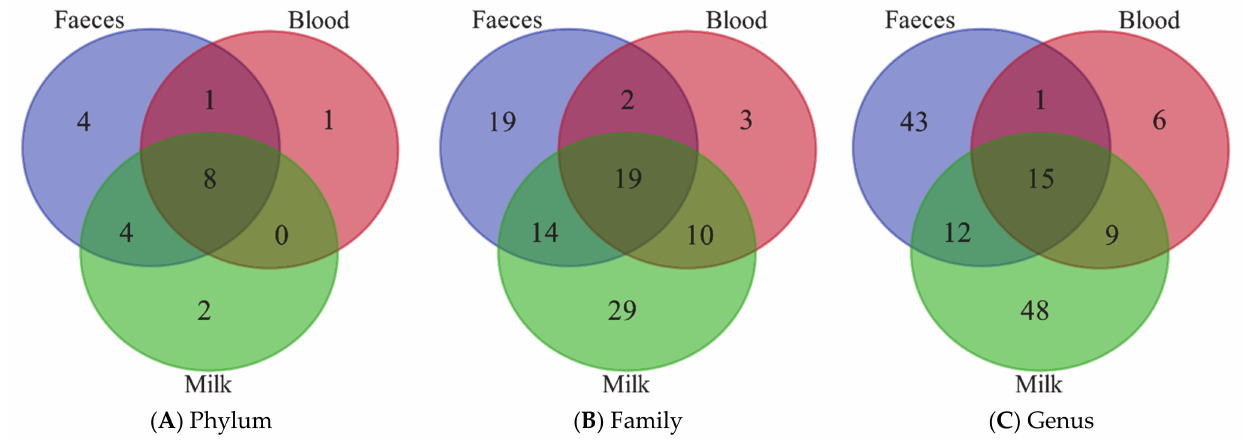
Figure 3. Venn diagrams showing the phyla ( A ), families ( B ) and genus ( C ) shared between milk, blood and milk samples from the lactating